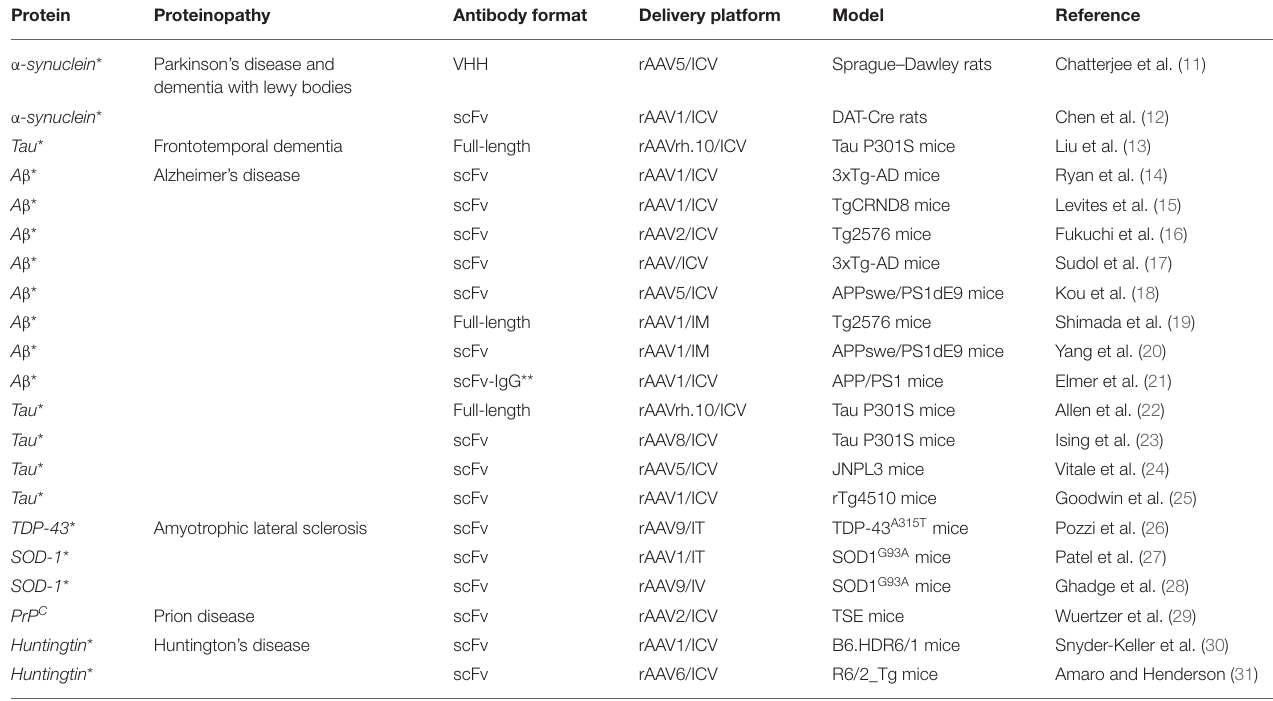
TABLE 1 | List of A-MAD approaches in preclinical models of the most common CNS proteinopathies.